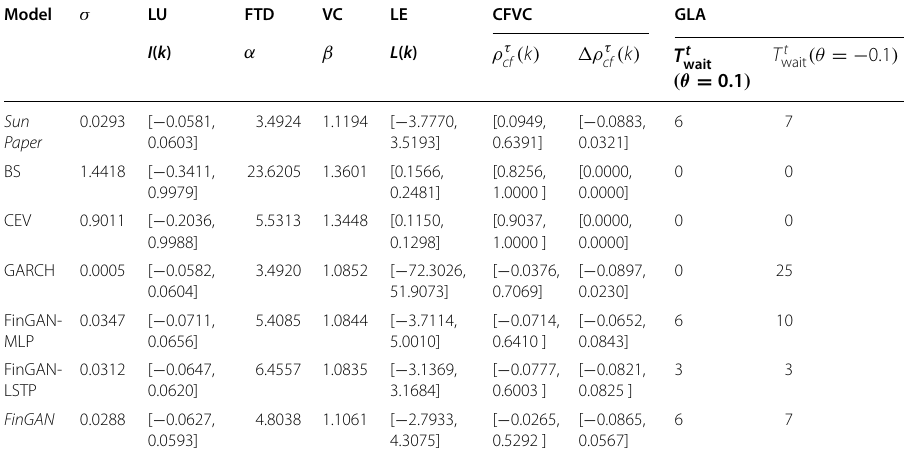
Table 3 Reproducibility of statistical properties with different